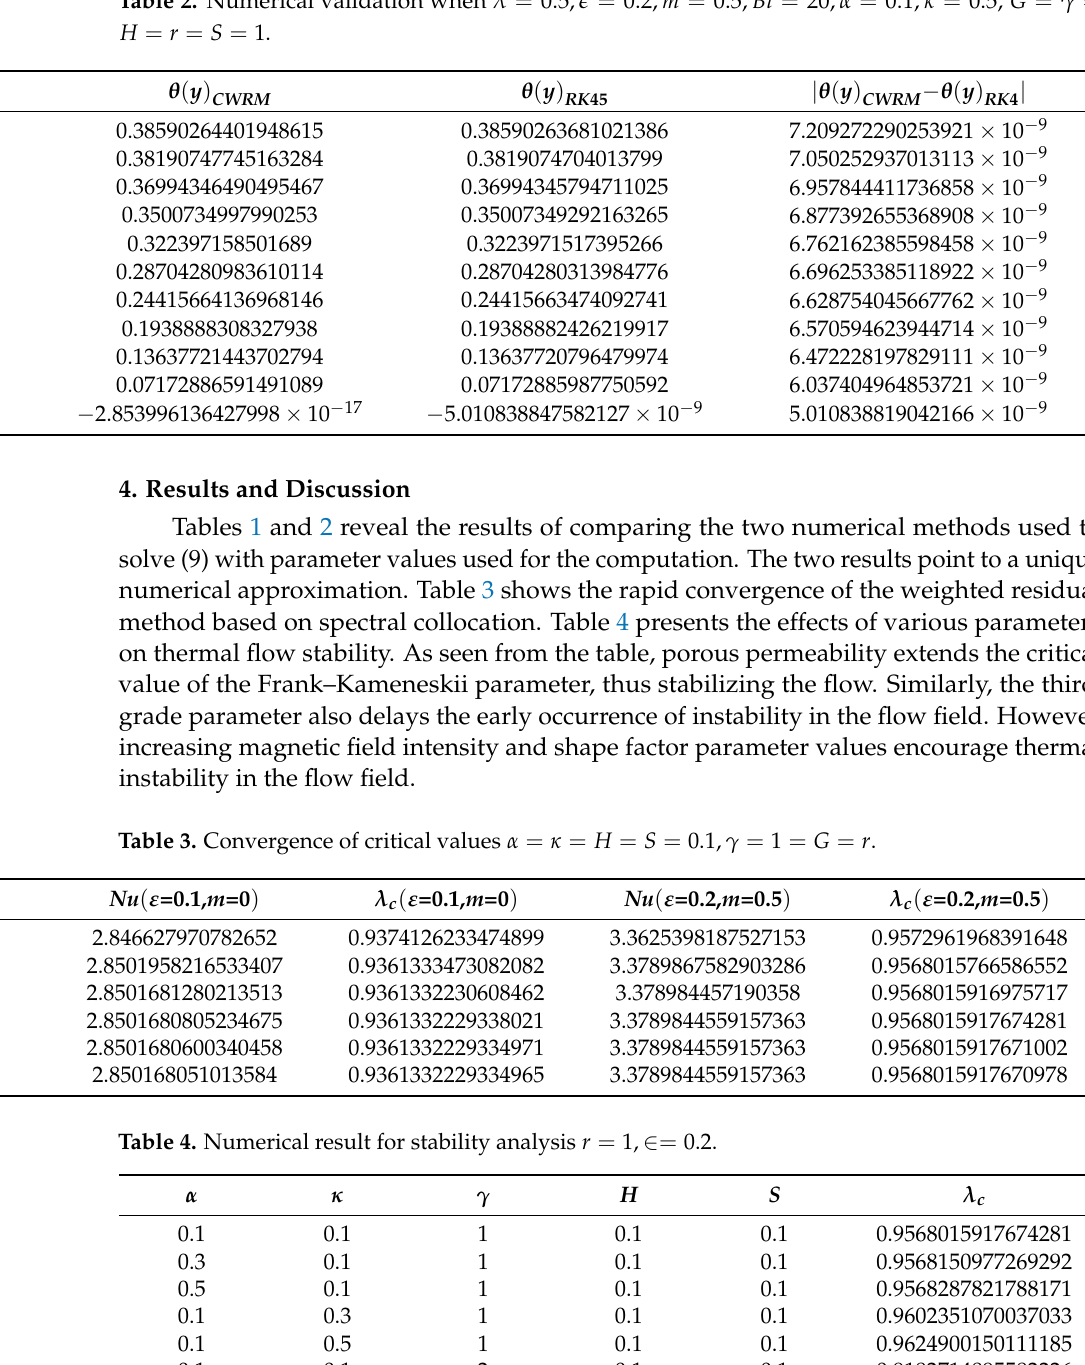
Table 2. Numerical validation when λ = 0.5, (cid:101) = 0.2, m = 0.5, Bi = 20, α = 0.1, κ = 0.5, G = γ =